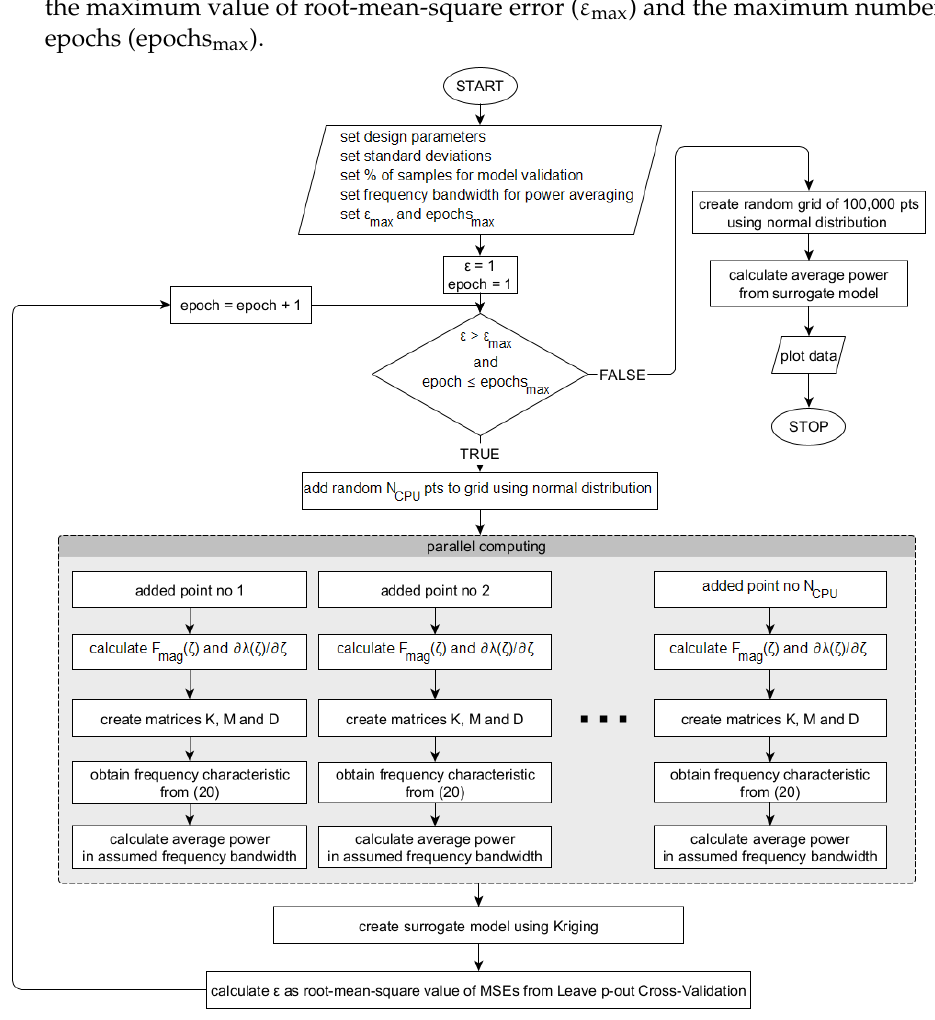
Figure 7. Flowchart diagram illustrating algorithm for creating surrogate model for fast computation of average power in assumed frequency bandwidth. N CPU —number of processor cores, MSEs—mean squared errors.